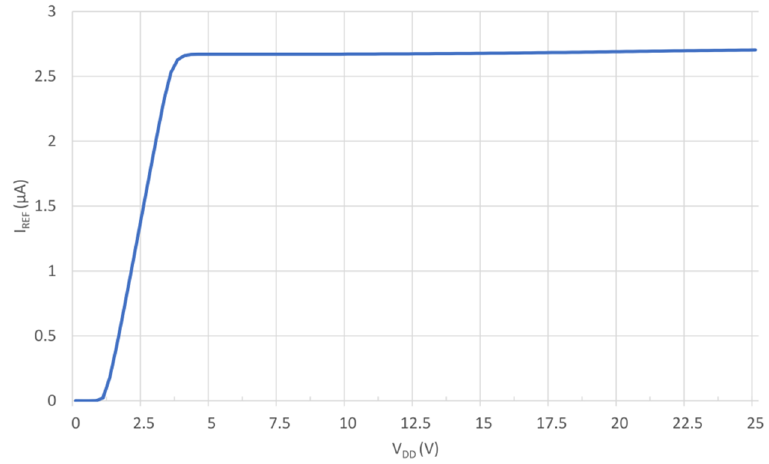
Figure 7. Reference current versus supply voltage (TT corner, room temperature).